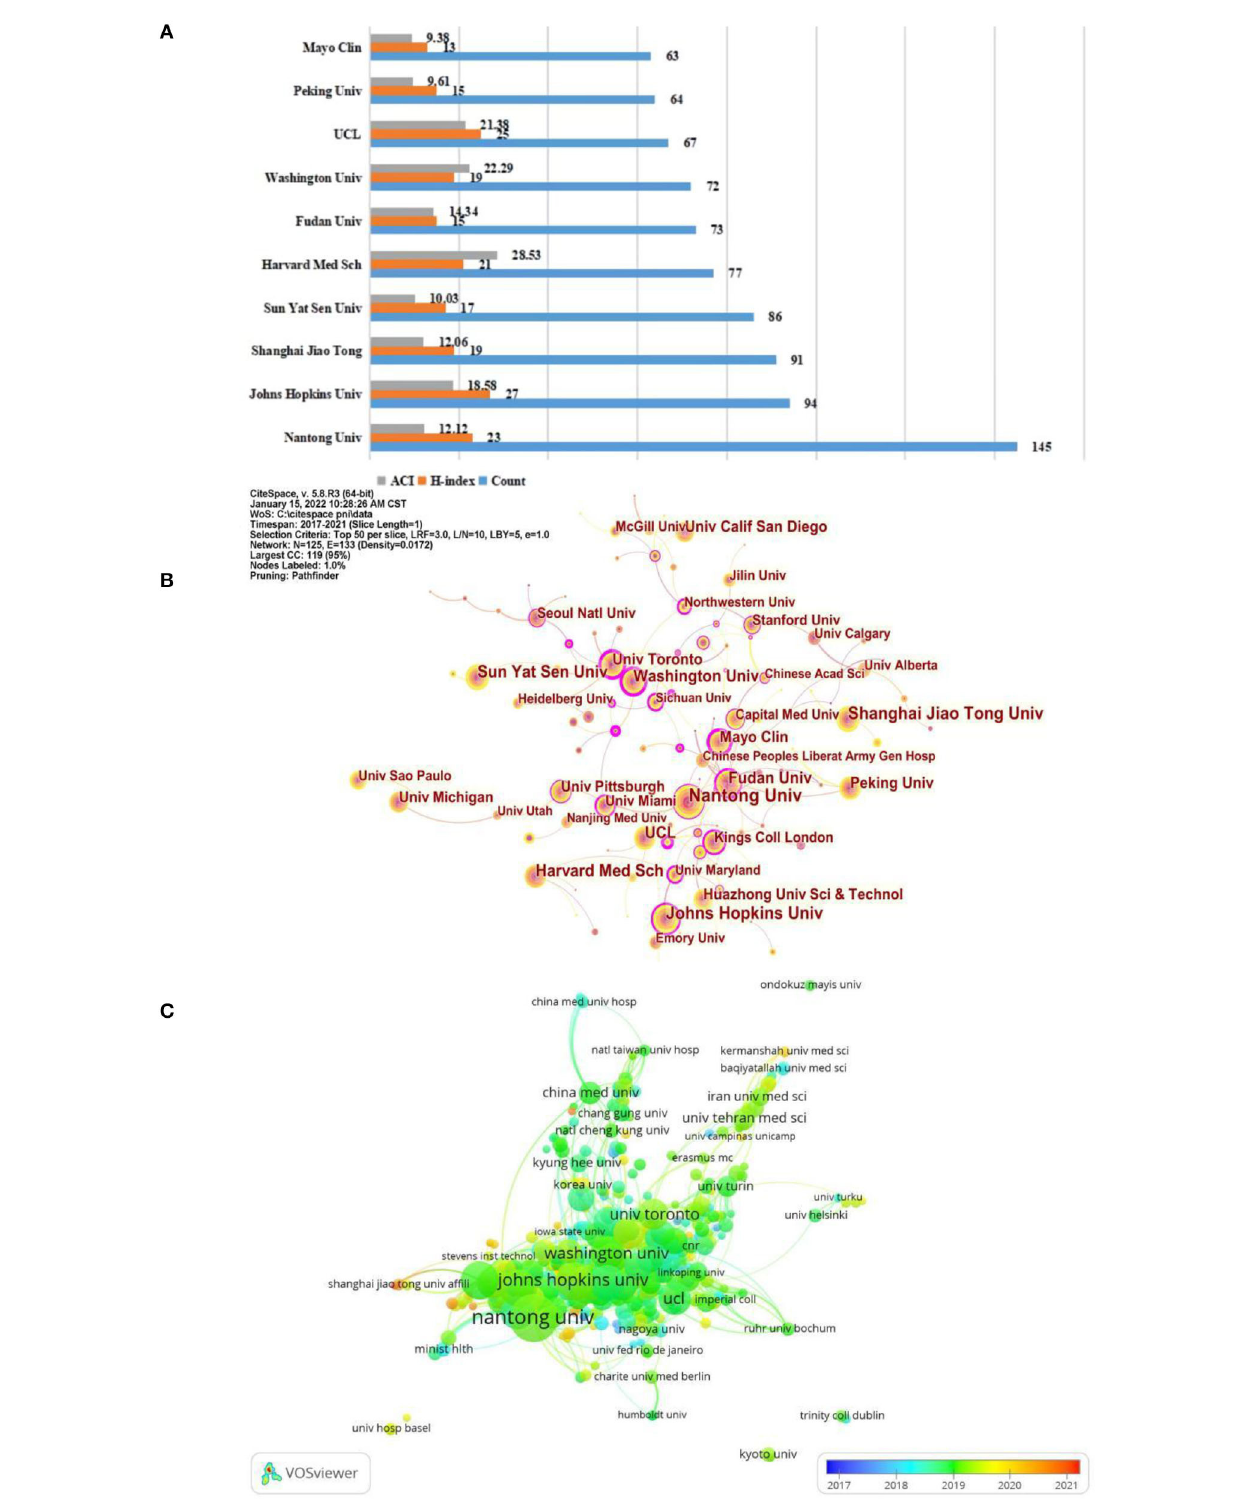
FIGURE 3 | (A) The publication counts, h-index, and ACI of the top 10 most prolific institutions. (B) Visualization map of institutions’ cooperative relationship by using CiteSpace software. (C) Coverage visualization map of institutions co-authorship analysis by using VOSviewer software.